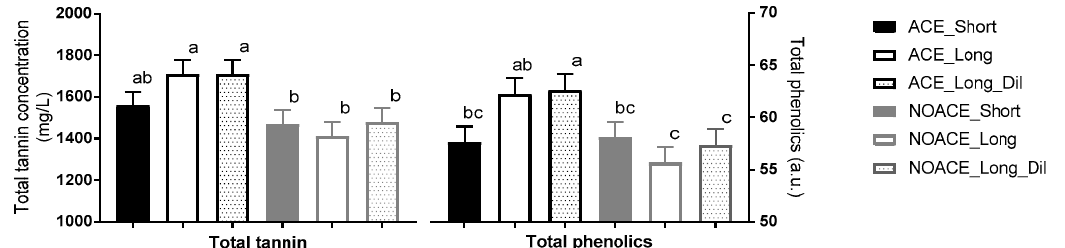
Figure 4. Mean total tannin concentrations and total phenolics (± standard error) of Shiraz wines prepared following NOACE and ACE maceration with either 3 days (Short) or 6 days (Long) on skins, or 6 days on skins with pre-fermentation water dilution to 13.5 Bé (Long_Dil). Different superscript letters above the bars indicate significant differences ( p < 0.05) between treatments analysed by LSD. The a.u. in the right axis is absorbance units.